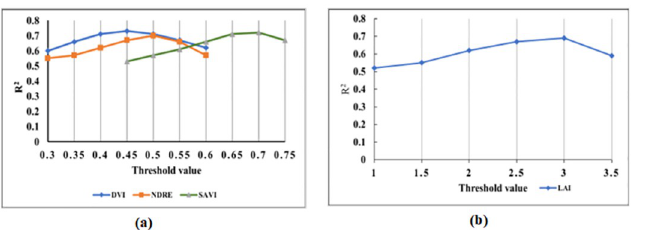
Fig 7. The change in a coefficient of determination ( R 2 ) with the selected threshold value for three vegetation indices DVI, NDRE, and SAVI a) and LAI b) with UAV image taken at DAP-96.